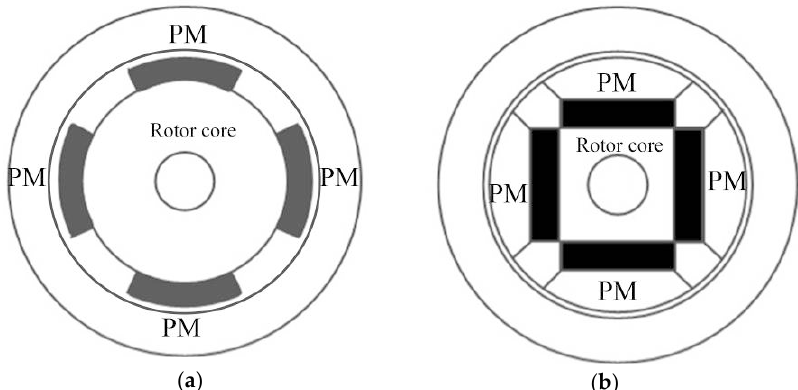
Figure 2. Alternatives of the rotor topologies in this paper: ( a ) surface-type; ( b ) interior-type.